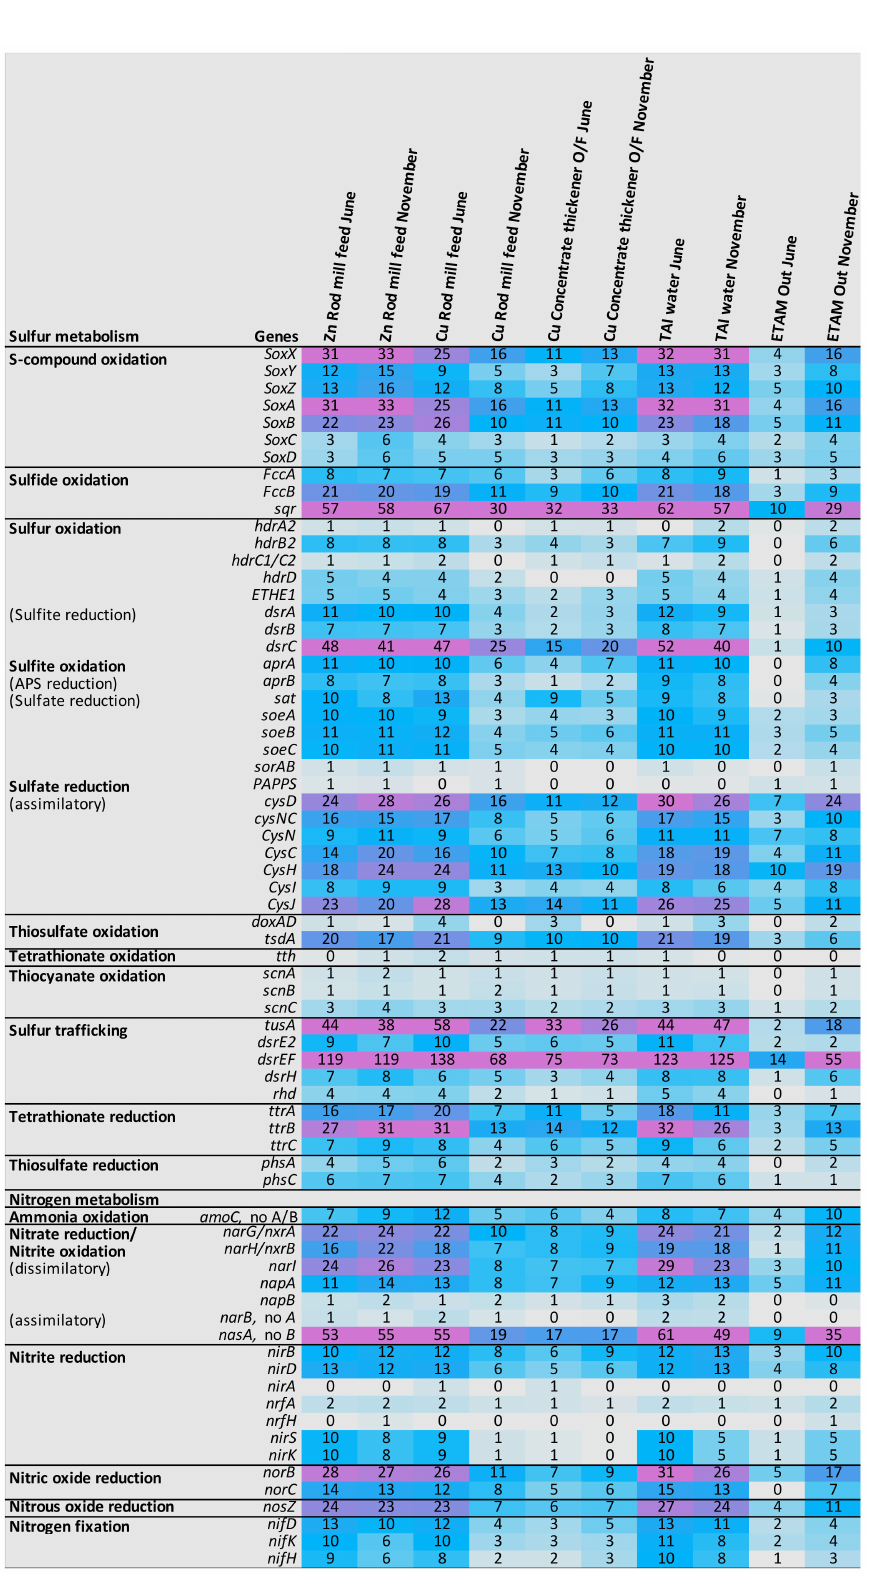
Figure 10. Sulfur and nitrogen metabolism related genes from the annotated metagenomic “detection” data from each sample. Gene counts are sums of all subunits if named together. Genes classified to certain reduction/oxidation reaction may also perform other reactions but are only listed once. The colours highlight the gene amounts and start to change from grey to blue with the first detected gene and from blue to purple after 10 detected genes. No colour change after 30 detected